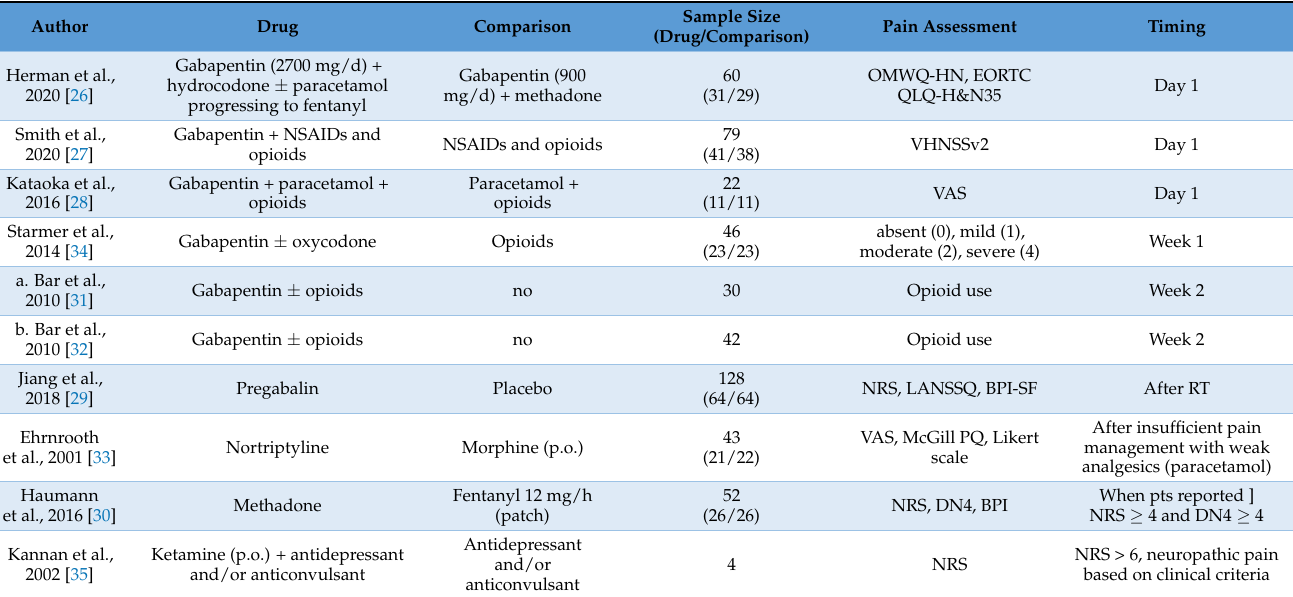
Table 2. Used tools and timing to evaluate the analgesic efficacy of the used therapy.